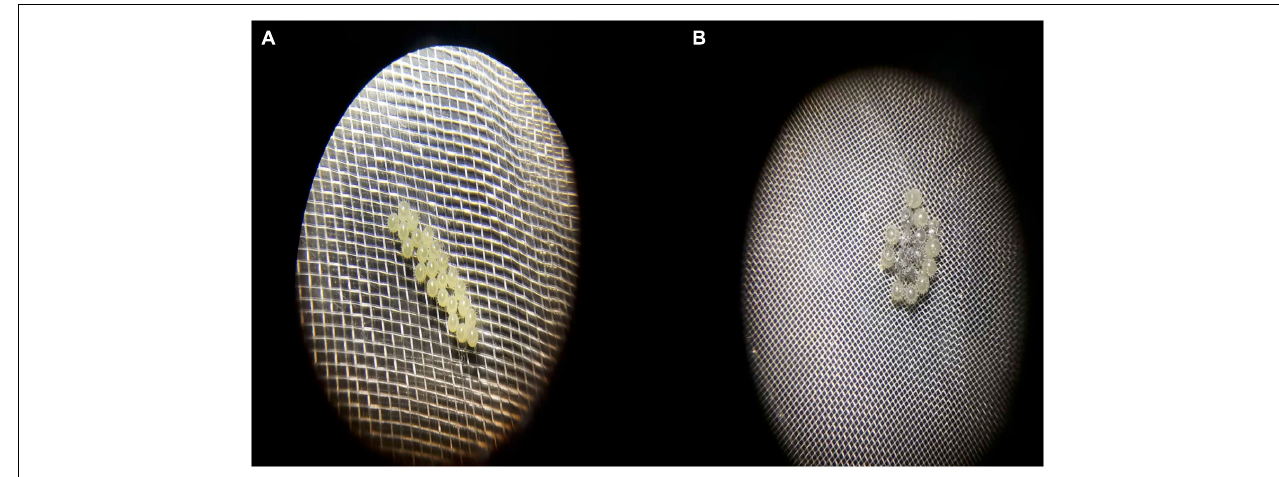
FIGURE 3 | Normal eggs (A) and cannibalized eggs (B) . The normal eggs were integral, round, smooth, and yellow, the cannibalized eggs were tattered, dim, shrunken, and silver-white.